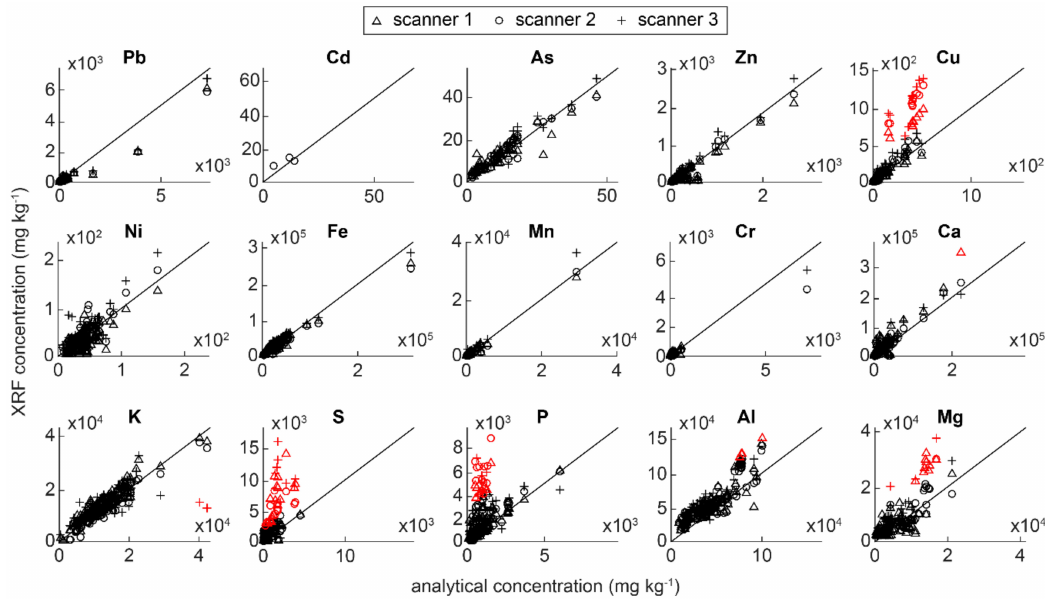
Figure 2. Scatterplots of X-ray fluorescence (XRF) versus laboratory results. Scatterplots of the element concentrations measured by XRF compared to laboratory analysis for each element and each tested XRF scanner. The 1:1-line is represented in black. Overestimated and underestimated samples for which abs[scaled dissimilarity] > 0.5 are shown in